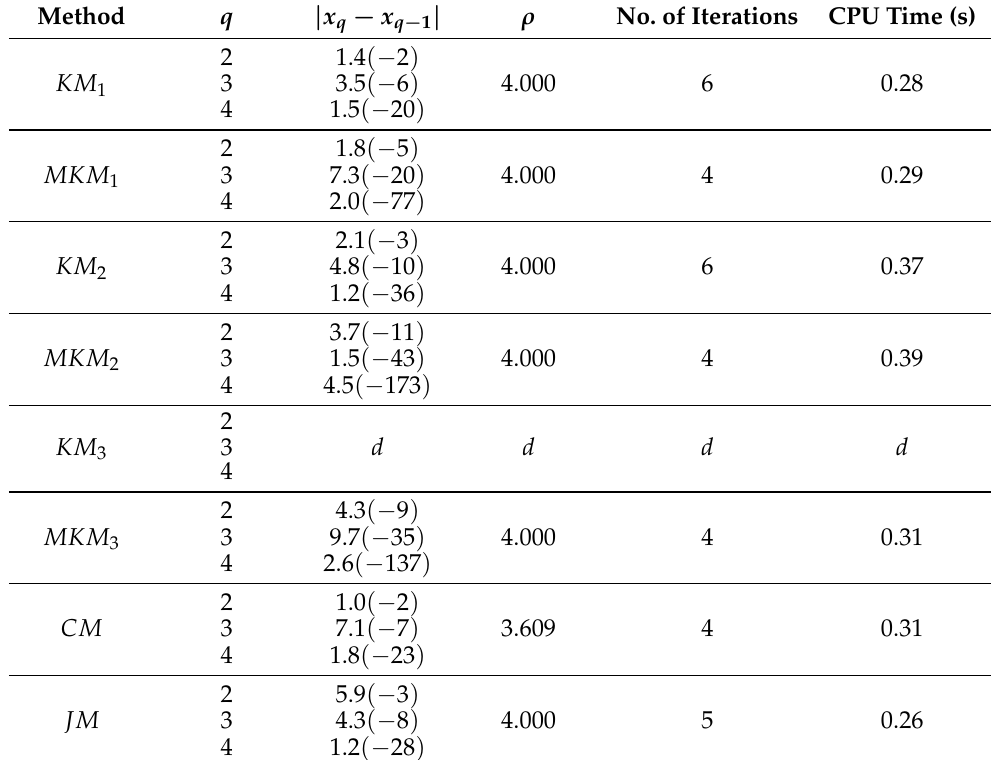
Table 5. Example 4(b) with initial guess x 0 =